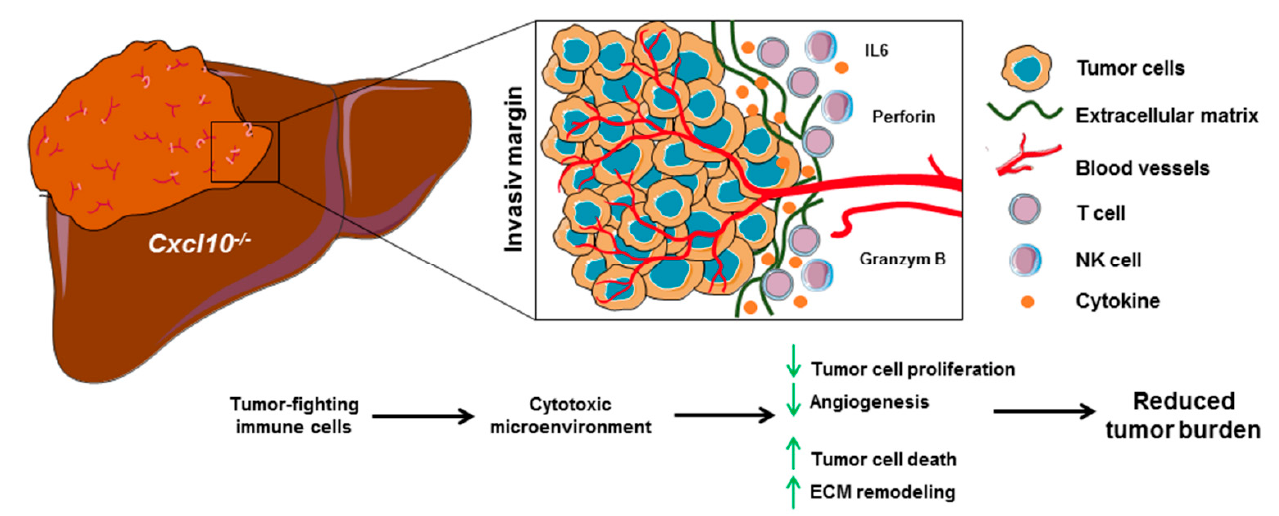
Figure 8. The chemokine CXCL10 shapes the intrahepatic tumor microenvironment during fibrosis- associated HCC progression. Deletion of Cxcl10 promotes the infiltration of tumor-fighting immune cells to the tumor site. Particularly, T cells and NK cells form a destructive boundary around the HCCs and induce a cytotoxic microenvironment. Furthermore, CXCL10 affects the entire chemokine/chemokine receptor network, tumor stoma composition, tumor cell proliferation and angiogenesis. Taken together, these effects lead to a reduced tumor burden. CXCL10 is a promising therapeutic target for the modulation of the tumor microenvironment .